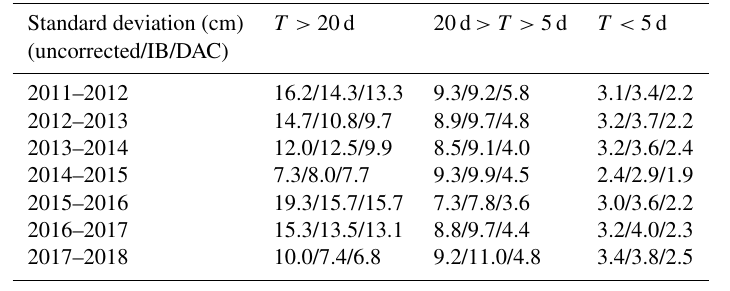
Table B1. Standard deviations of the three time series of along-track η (cid:48) , averaged over the East Siberian Sea box (Fig. B1), using uncorrected η (cid:48) , η (cid:48) corrected by IB and η (cid:48) corrected by DAC. For each year only ice-covered data are used, in the months November to July. Standard deviations are presented for the time series filtered in three different frequency bands.